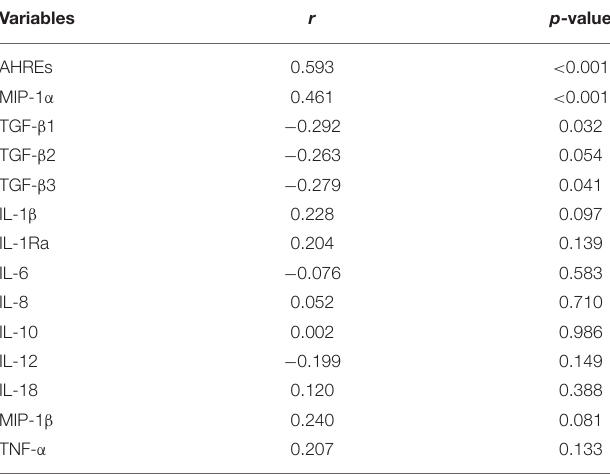
TABLE 2 | Correlation between left atrial (LA) volume and atrial high-rate episodes (AHREs) and between LA volume and cytokines in patients with AF.